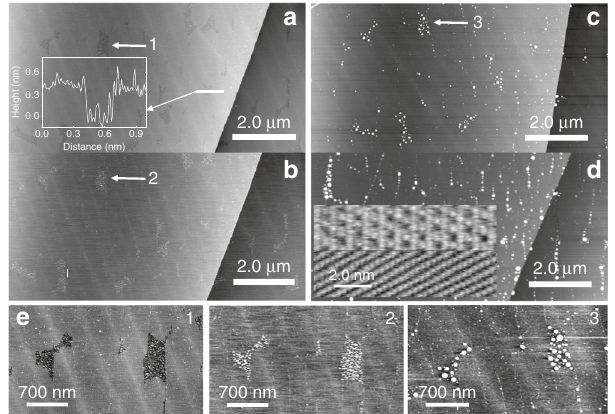
Fig. 5 Exposure of the melamine cyanurate-terminated black phosphorus surface to atmosphere. a – c A sequence of tapping mode AFM scans of the same area showing partial oxidation on uncoated areas of the